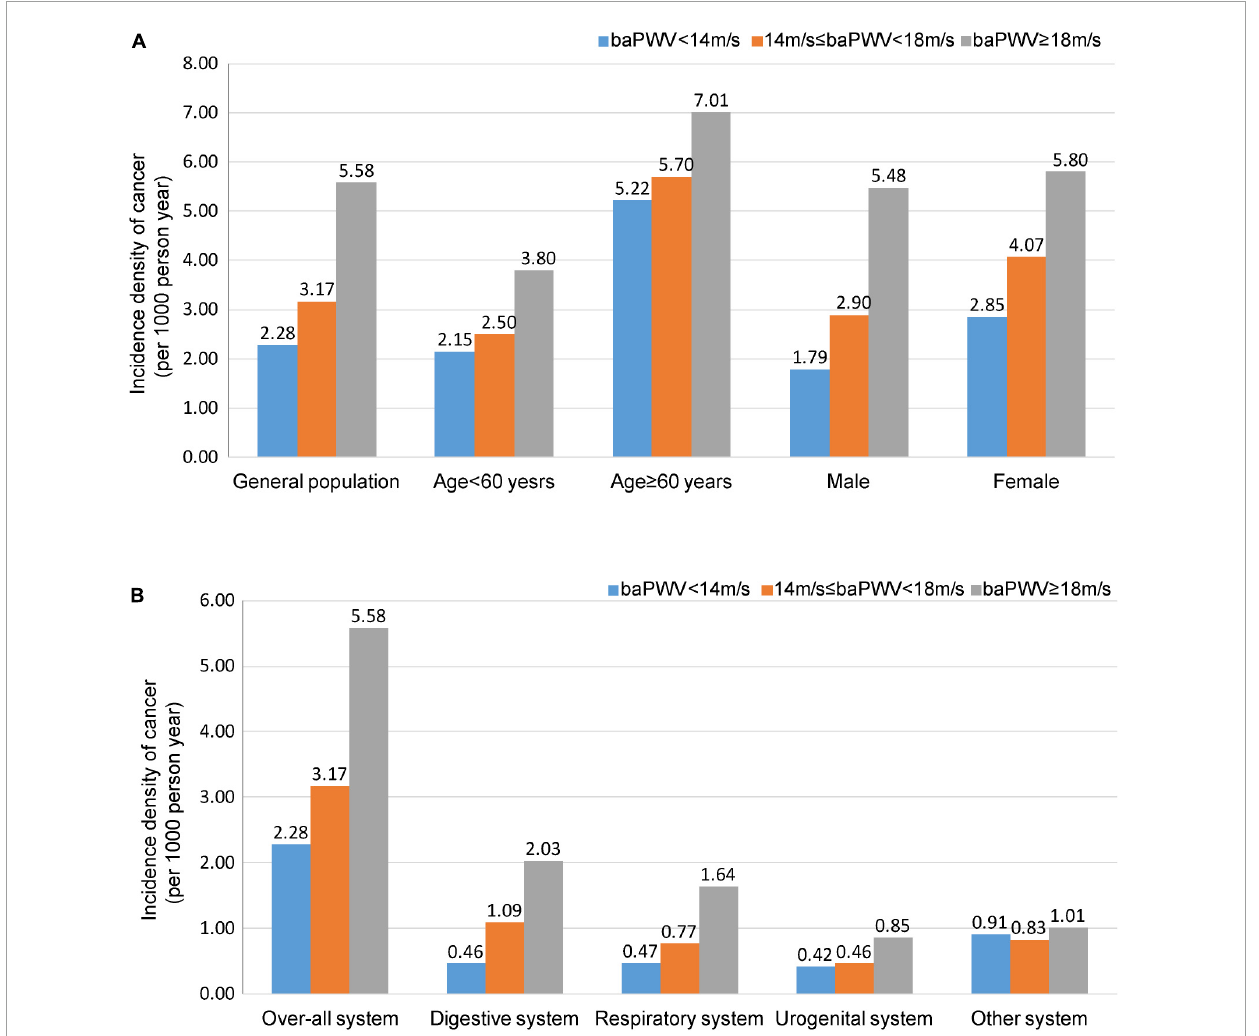
FIGURE2 Incidence density of cancer. Participants are categorized into three groups: baPWV < 14.0 m/s, 14.0 ≤ baPWV < 18.0 m/s, and ≥ 18.0 m/s. Incidence density of cancer in the general population, men, women, individuals < 60 years old, and individuals ≥ 60 years old. (A) Incidence density of cancer in the different systems. (B) Values are presented as per 1,000-person year. baPWV, Brachial-ankle pulse wave